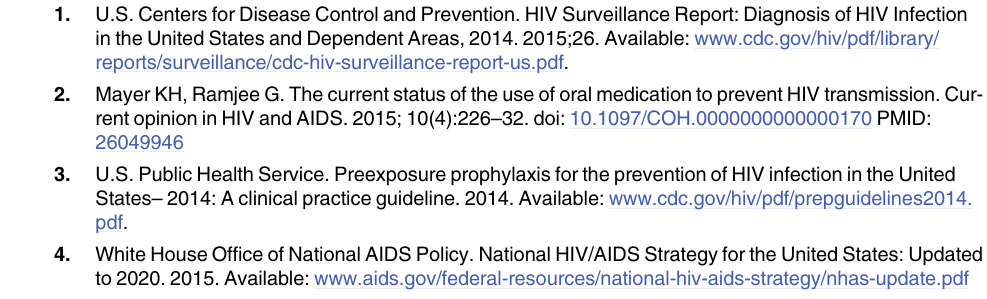
S1 Fig. Background